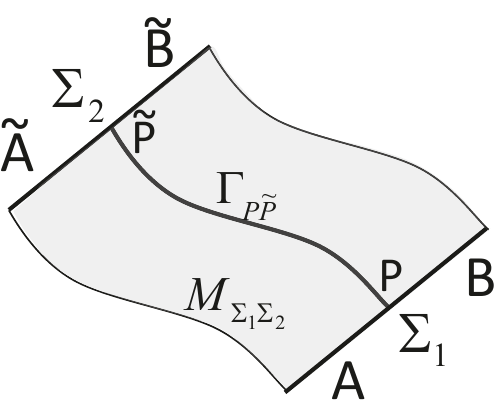
Figure 8 . The path-integration on M (cid:6) quantum